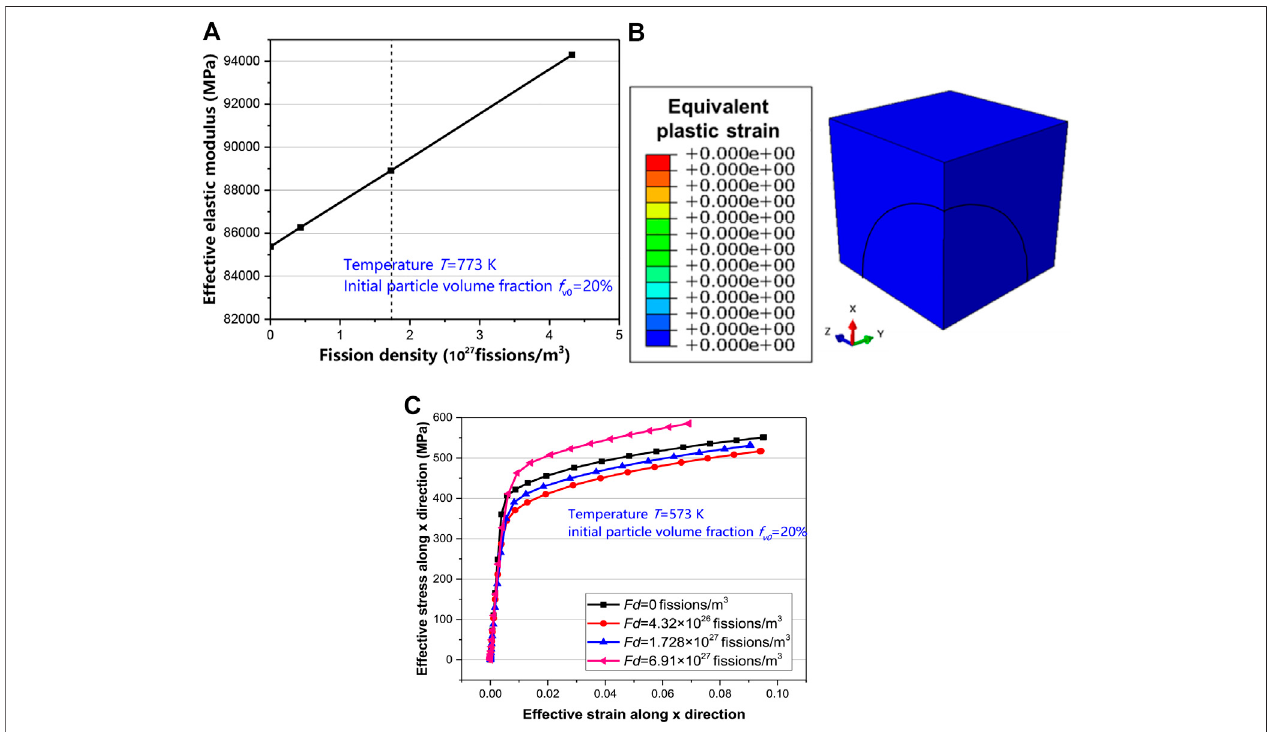
FIGURE 10 | Postirradiation (A) effective elastic modulus and (B) equivalent plastic strain of the composite after irradiation of 4.32 × 10 26 fi ssions/m 3 and (C) effective elastoplastic curves after different fi ssion densities.